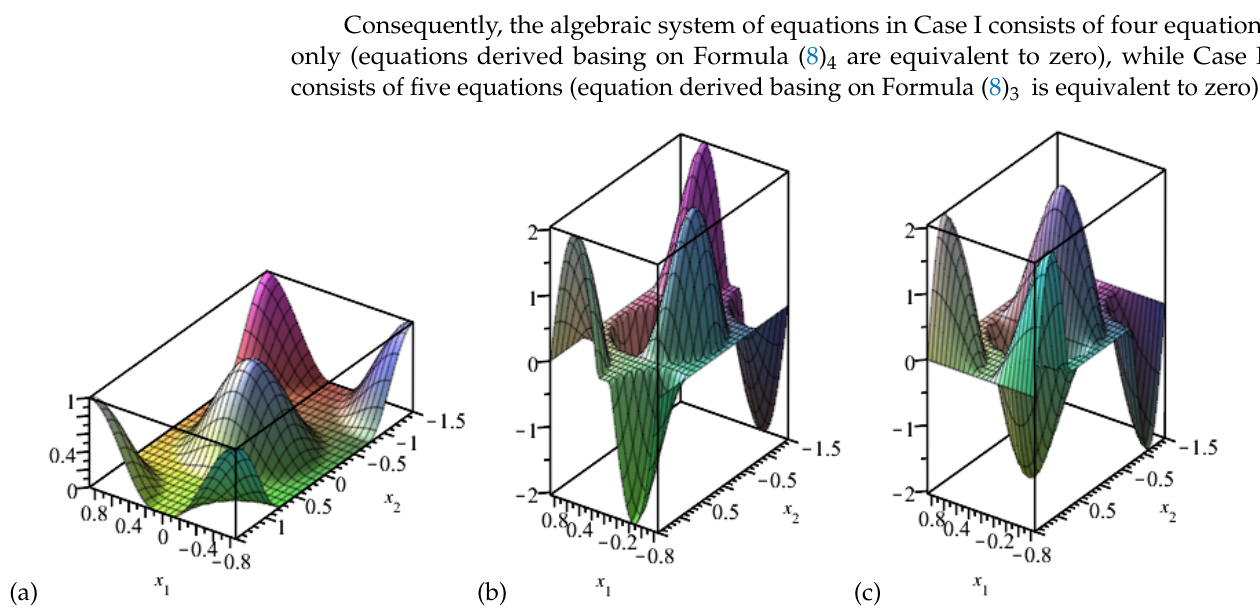
Figure 5. Visualisation of the assumed fluctuation shape functions: ( a ) ˜ g 1 , ( b ) ˜ h 1